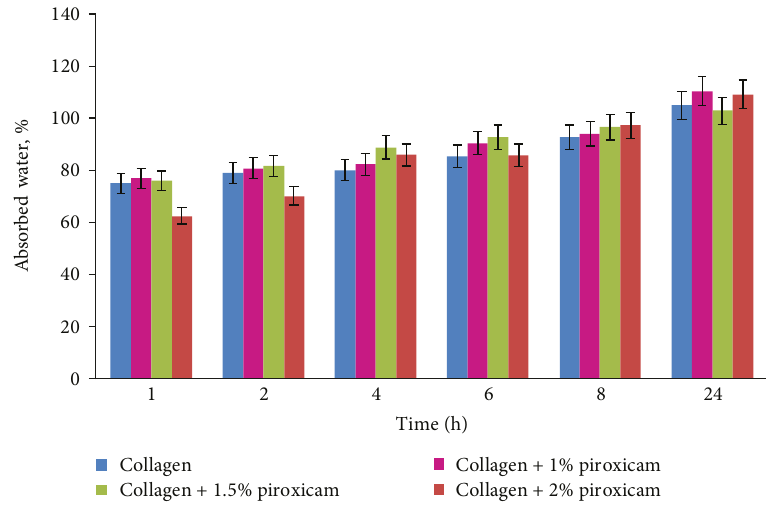
Figure 1: Water absorption of piroxicam